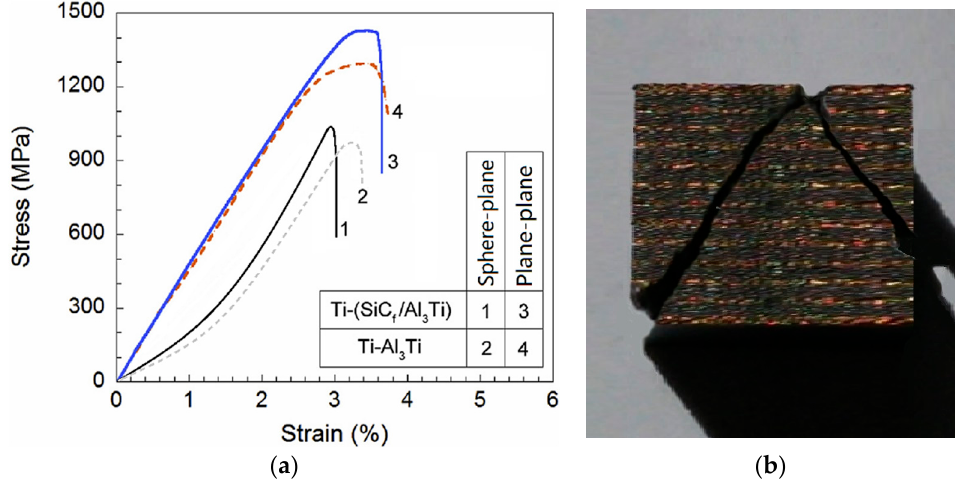
Figure 19. ( a ) Compressive stress-strain curves for Ti-(SiC f /Al 3 Ti) and Ti-Al 3 Ti laminated composites at different contact mode of loading and ( b ) the damaged specimen after material failure under sphere-plane contact load.